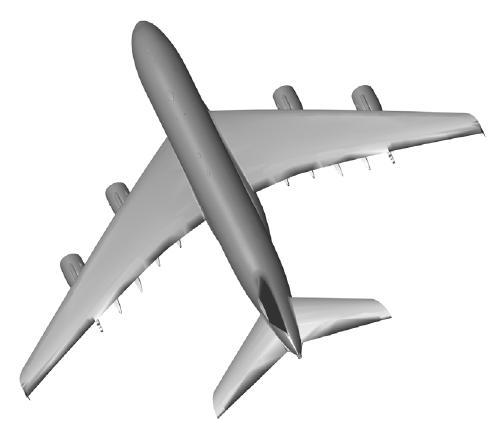
Figure 8. CAD model of aircraft A380.